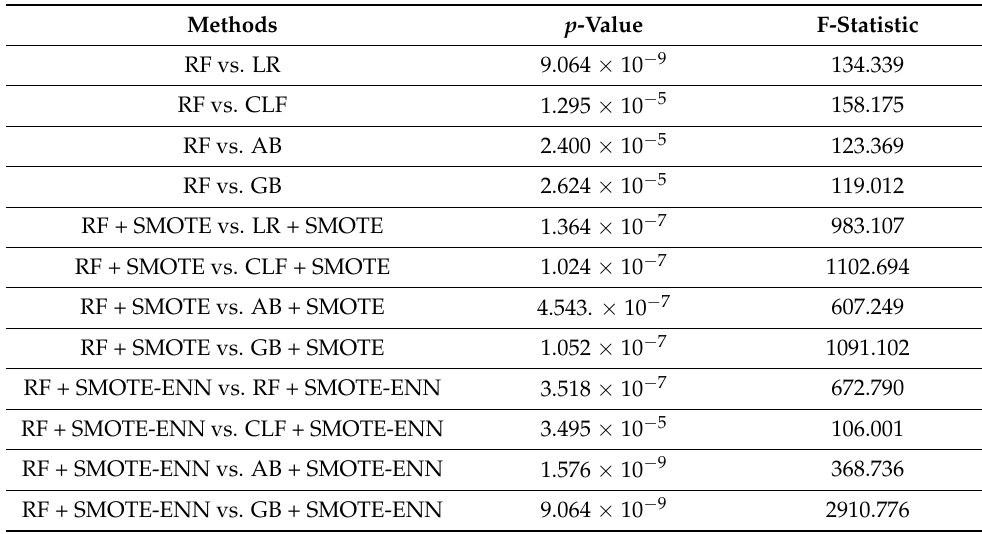
Table 5. Statistical significance of classifiers for hotel 1.